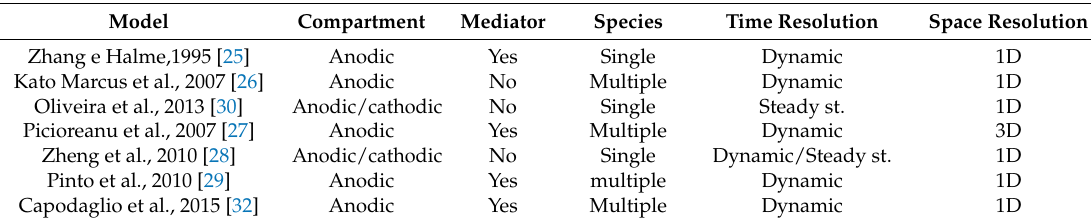
Table 1. Summary of published MFC